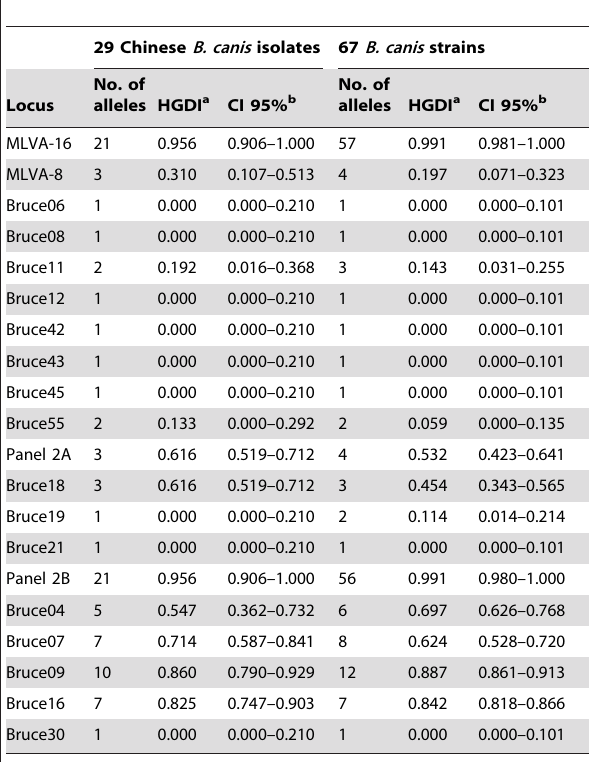
Table 2. Hunter-Gaston Diversity Index (HGDI) for the 67 Brucella canis